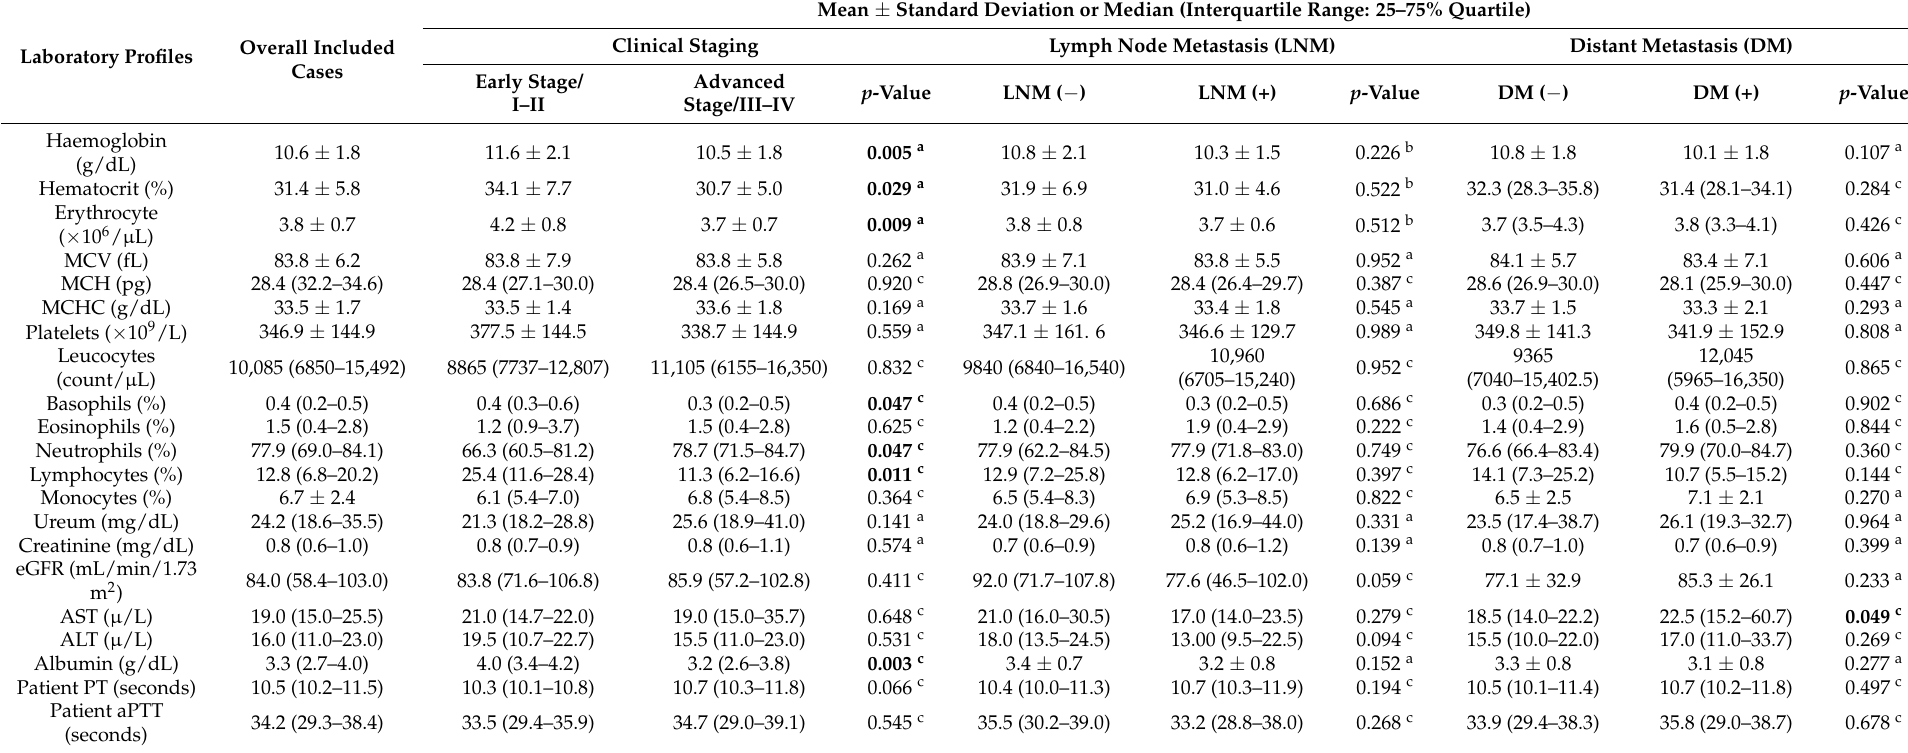
Table 3. Baseline characteristics of laboratory testing results in the form of haematological, chemistry, and haemostasis/clotting